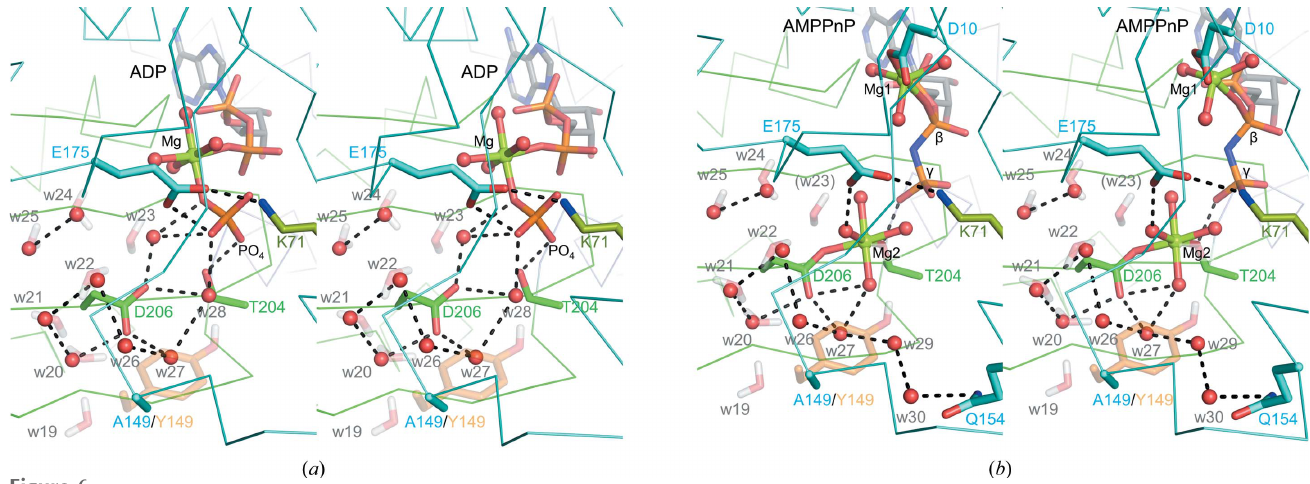
Figure 6 X-ray crystal structures of ( a ) Y149A-Hsp72 in complex with ADP (PDB entry 7f4z) and ( b ) Y149A-Hsp72 in complex with AMPPnP (PDB entry 7f50). The colour scheme is the same as in Figs. 2 and 3. The side chain of Tyr149 and water cluster 3 of the superposed joint XN structure (PDB entry 7f4x) are shown as a semi-transparent stick